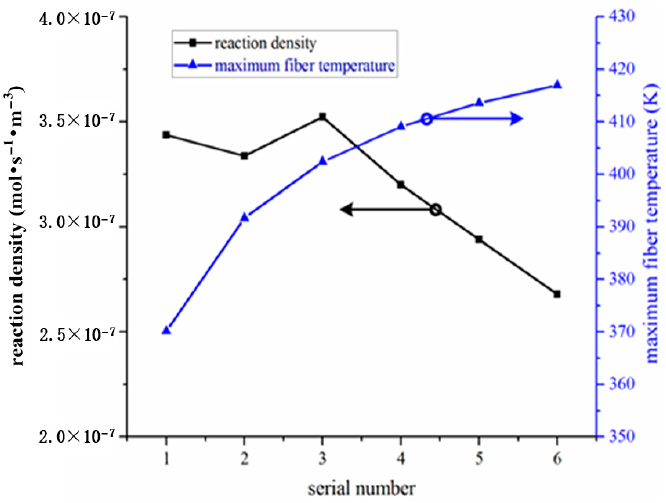
Figure 14. Variations of the reaction density and maximum fiber temperature with the serial number of reaction elements.